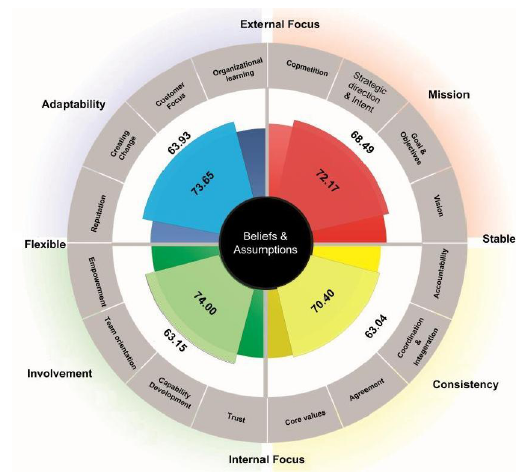
Fig. 4. Comparing Status Quo Trait Scores with Favorite Organizational Culture Using Success Indexes